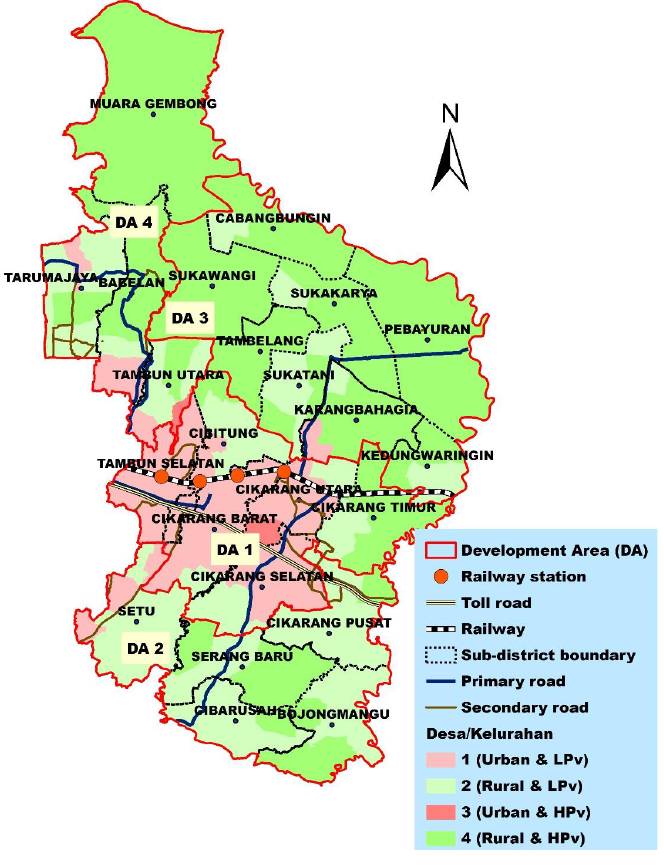
Figure 8. Delimitation and spatial patterns of economic disparities across urban and rural neighbor- hoods in 2018.